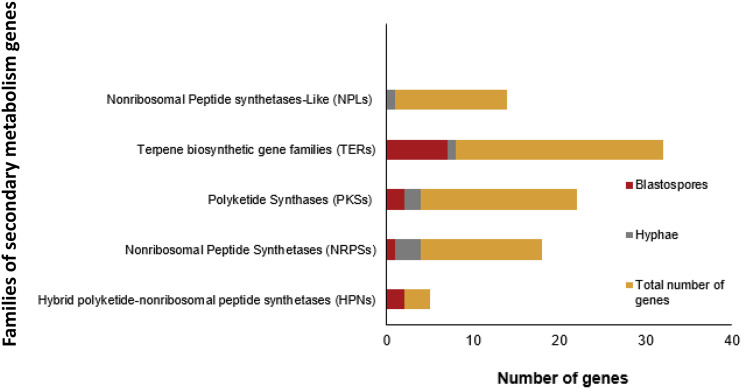
Number of genes in families of biosynthetic genes involved in secondary metabolism of Metarhizium. Up-regulated genes are represented by dark red bar for blastospores and gray bars for hyphae, FDR-pvalue < 0.001, log2FC > 4 (Additional file 9).